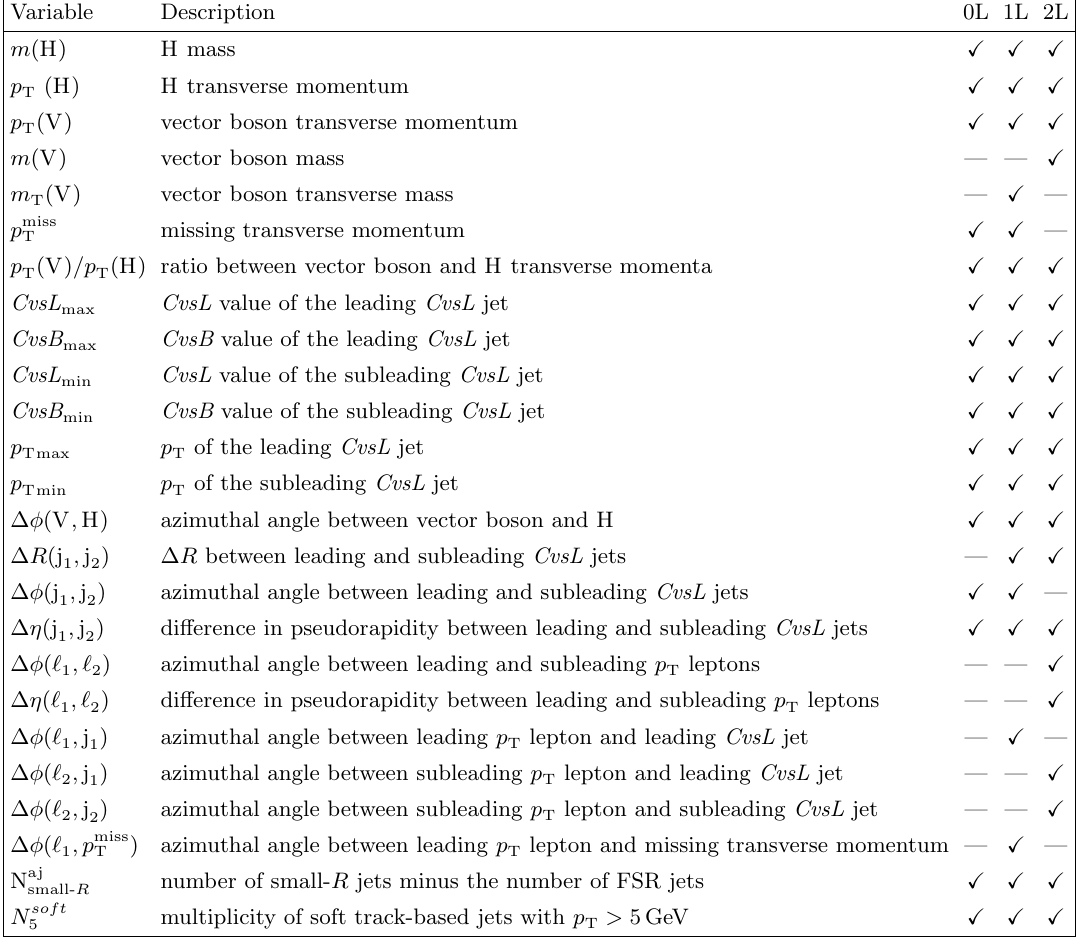
Table 1 . Variables employed in the training of the BDT used for each channel of the resolved-jet topology analysis. The 2L case has separate training for the low- and high- p exploits the same input